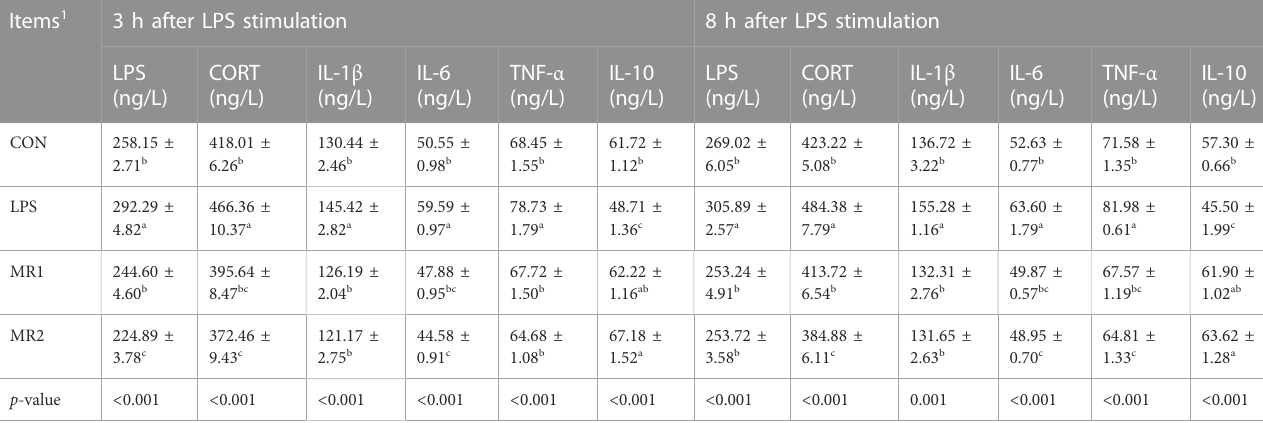
TABLE 8 Effects of dietary methionine restriction on serum stress indexes and pro-in fl ammation factors of LPS-stimulated broilers (n = 6). Items 1 3 h after LPS